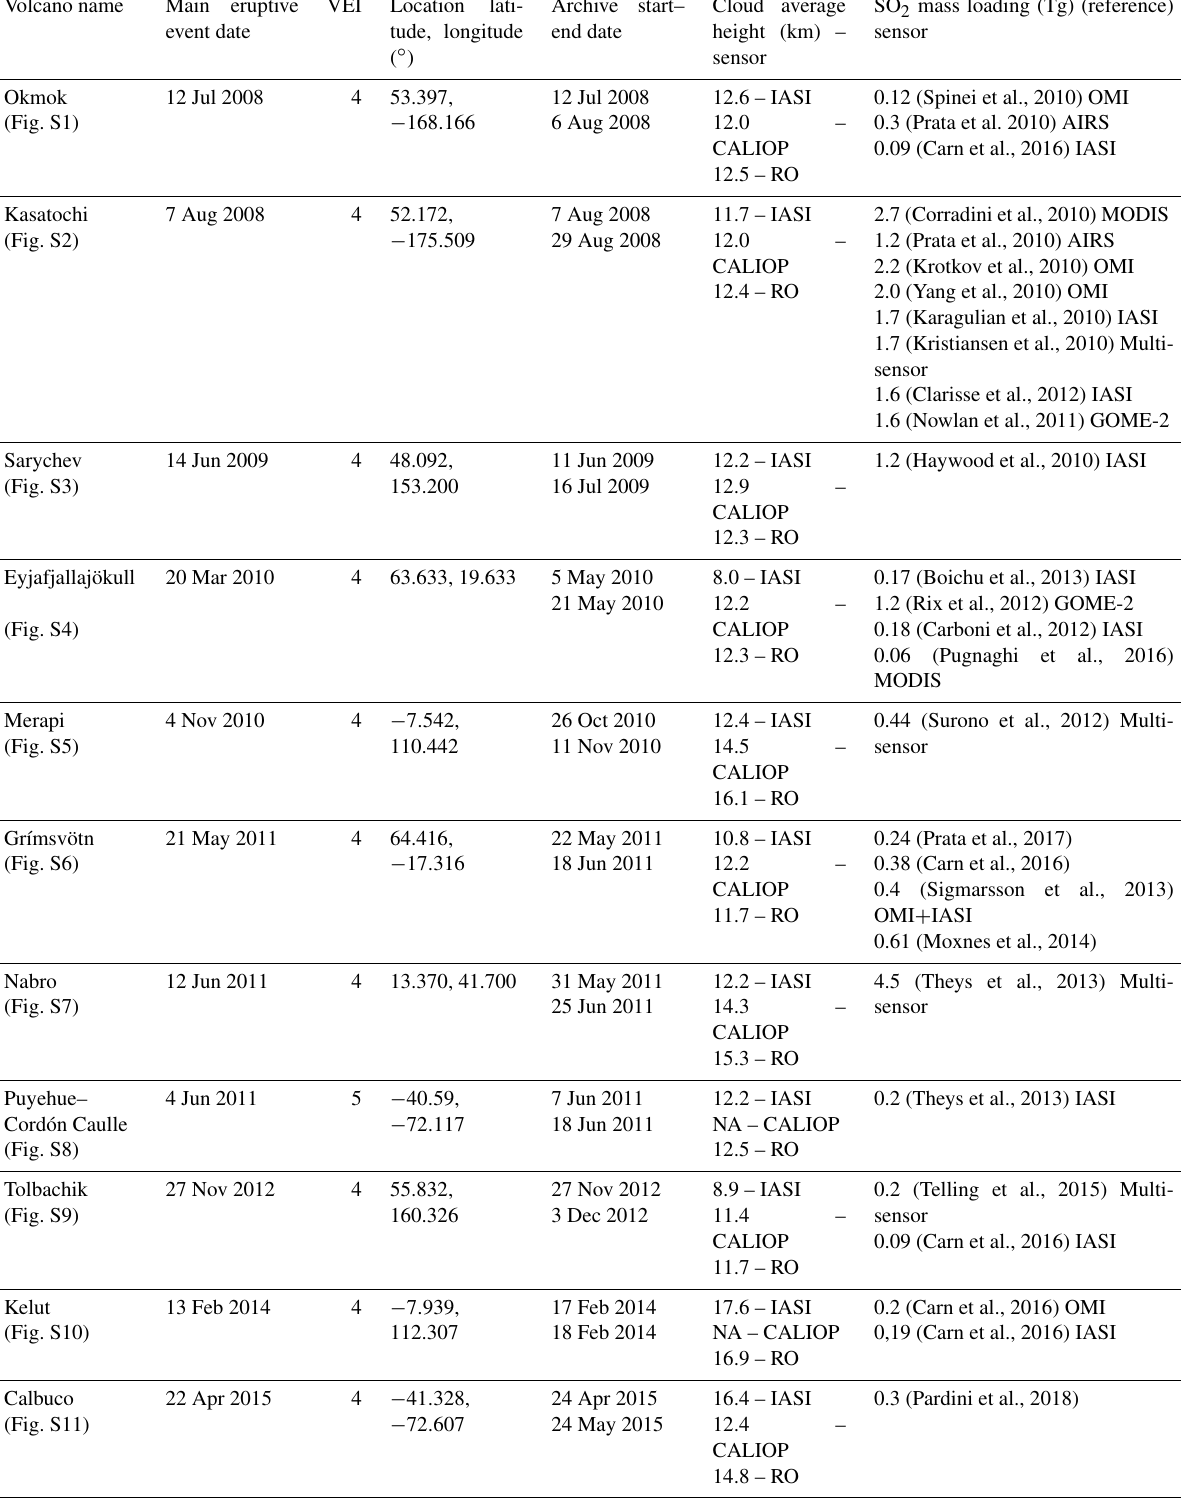
Table 2. Summary of the volcanoes and related eruption selected for the database. The following information is provided: the name of each volcano; the eruption start date as provided by the GVP; the spatial location of the volcano in latitude and longitude; the plume/cloud height as a range estimated from IASI, CALIOP and GNSS RO (see details below); and the SO 2 mass loading in teragrams as reported in the